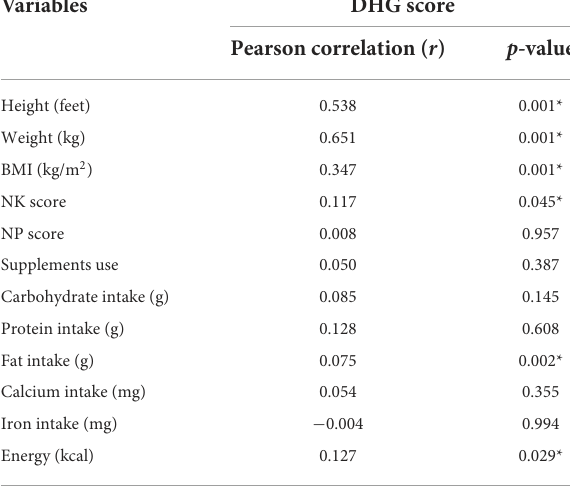
TABLE 5 Correlation of anthropometric measurements, nutrition knowledge, practice, and nutrient intake with strength performance among Taekwondo players ( n = 293).